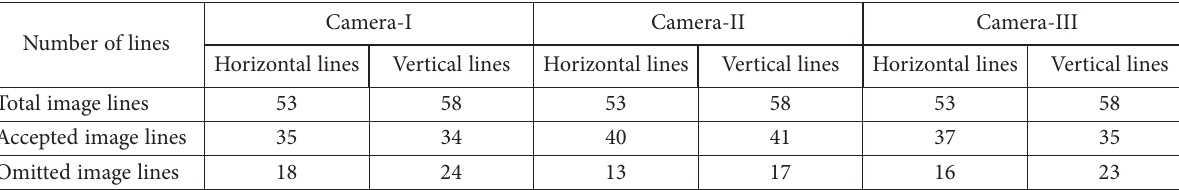
Table 2. Results obtained applying RANSAC algorithm